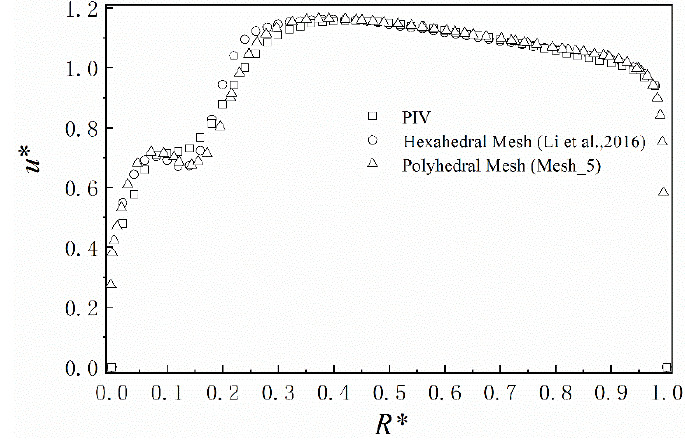
Figure 5. Comparison of PIV and CFD results obtained by different mesh types.